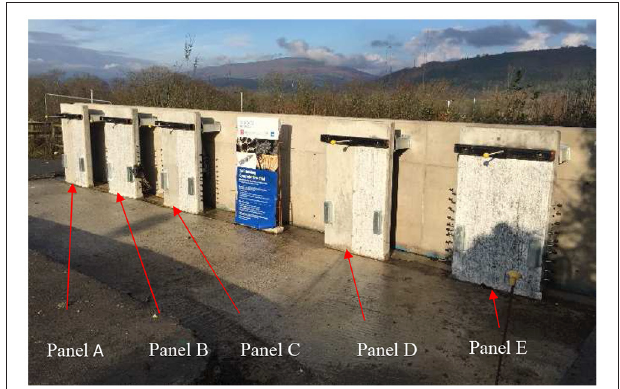
FIGURE 12 | Site trial panels after initial